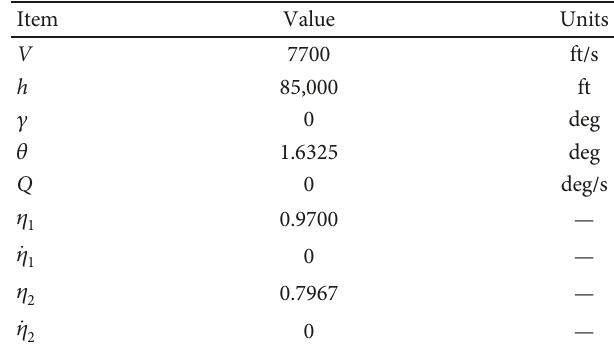
Table 1: Initial trim